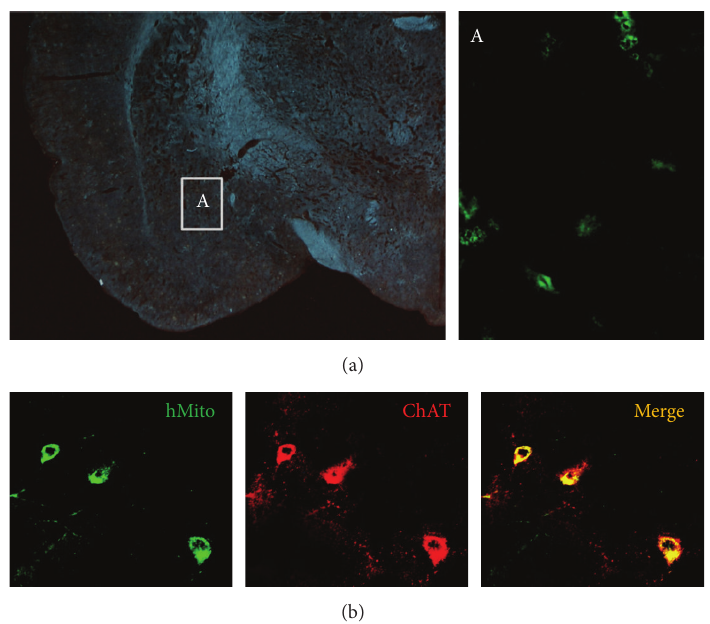
Figure 4: Representative images for detection of transplanted F3.ChAT cells in the amygdala (a) and for production of functional ChAT protein (b) 4 weeks after transplantation. ((a), inset A) For detection of human F3.ChAT cells, the amygdala tissue was immunostained with hMito antibody. (b) The cells were double immunostained with antibodies specific for hMito and ChAT. NMDA, N-methyl-d-aspartate; hMito, human mitochondria; ChAT, choline